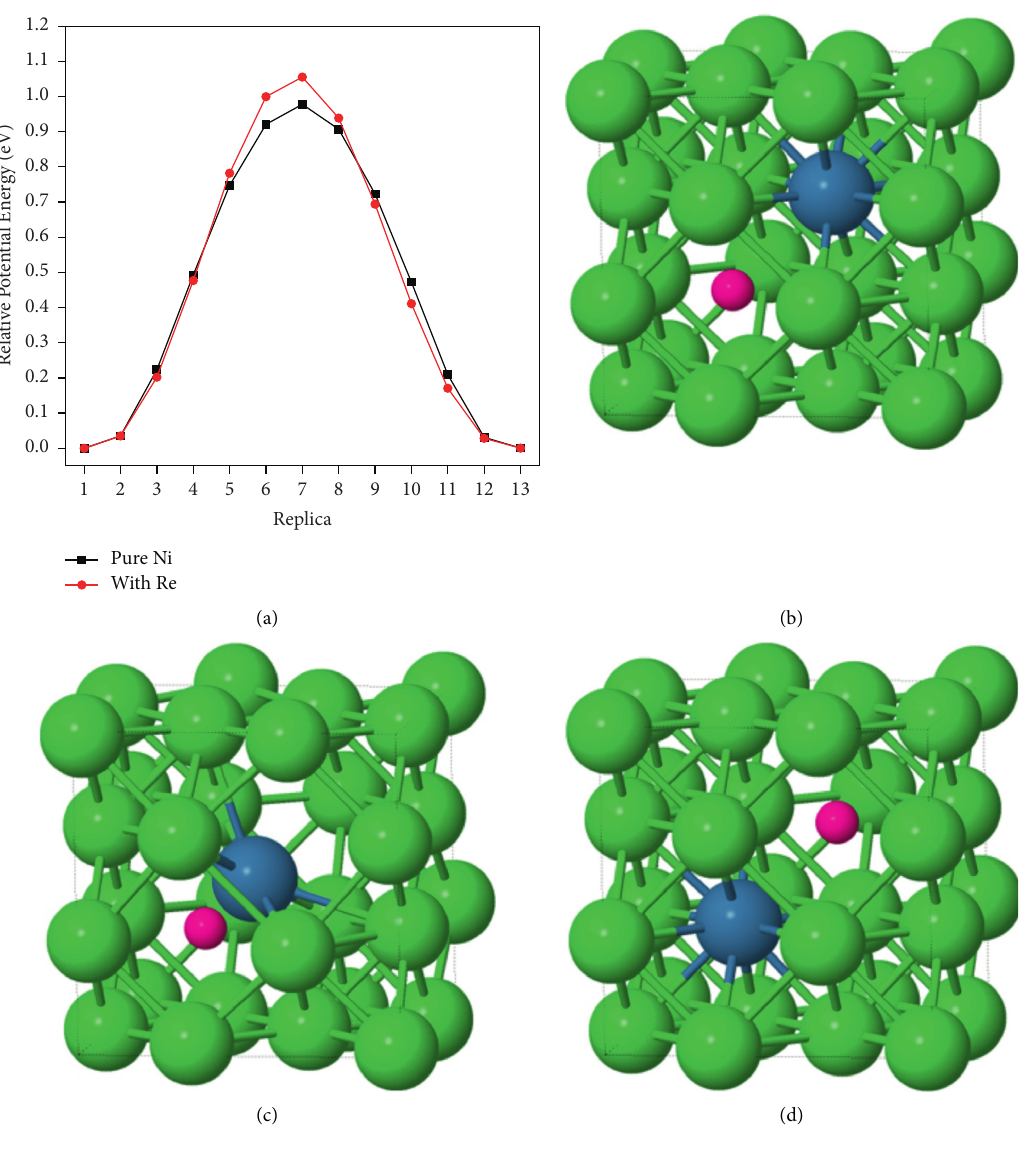
Figure 2: The exchange in location between Re atom and vacancy in the Ni-Re system is illustrated. The NEB relative potential energy from initial to final state is displayed in (a). (b), (c), and (d) represent initial, transition, and final states, respectively. The Re atoms are shown by the large blue spheres, and the vacancy is represented by smaller pinkish